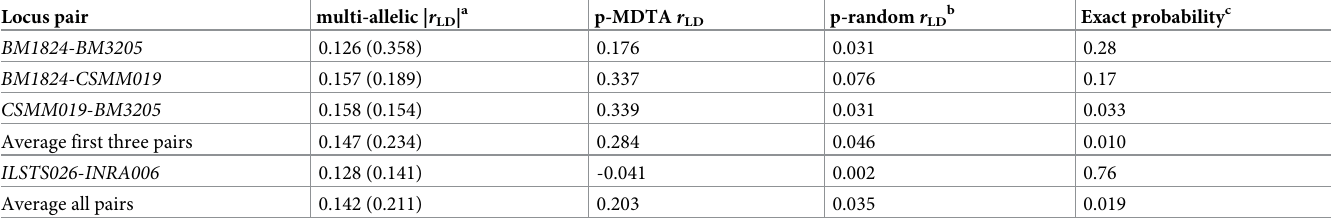
Table 3. Linkage disequilibrium in Kruger National Park among locus pairs showing significant LD in earlier studies. Locus